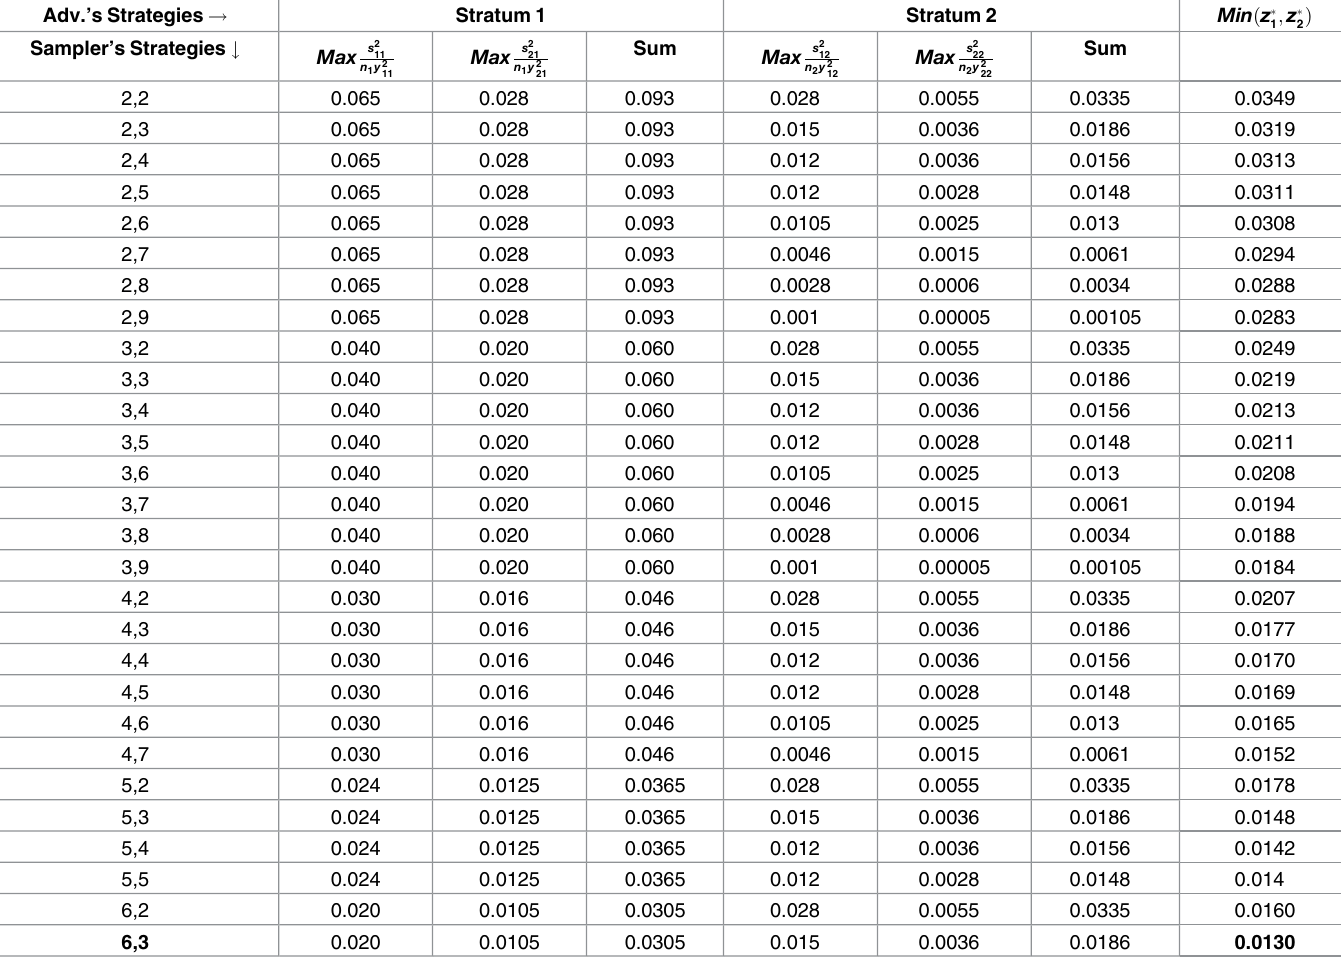
Table 2. Payoff Matrix of